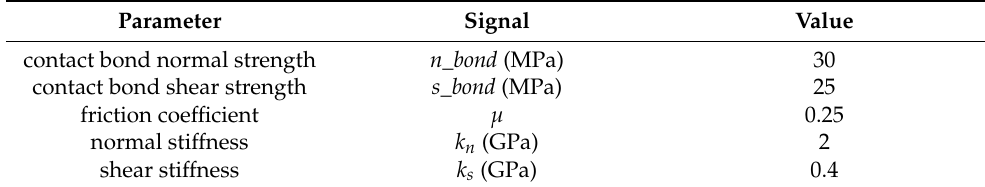
Table 2. Micromechanical parameters of the bedding model.